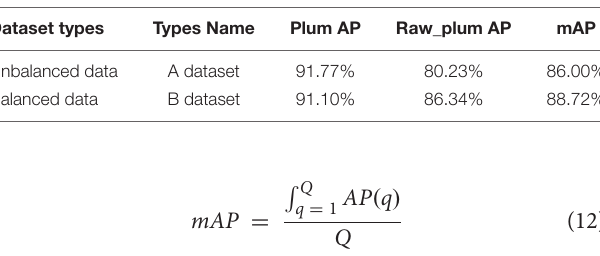
TABLE 2 | Comparison of recognition effect of the improved model before and after data